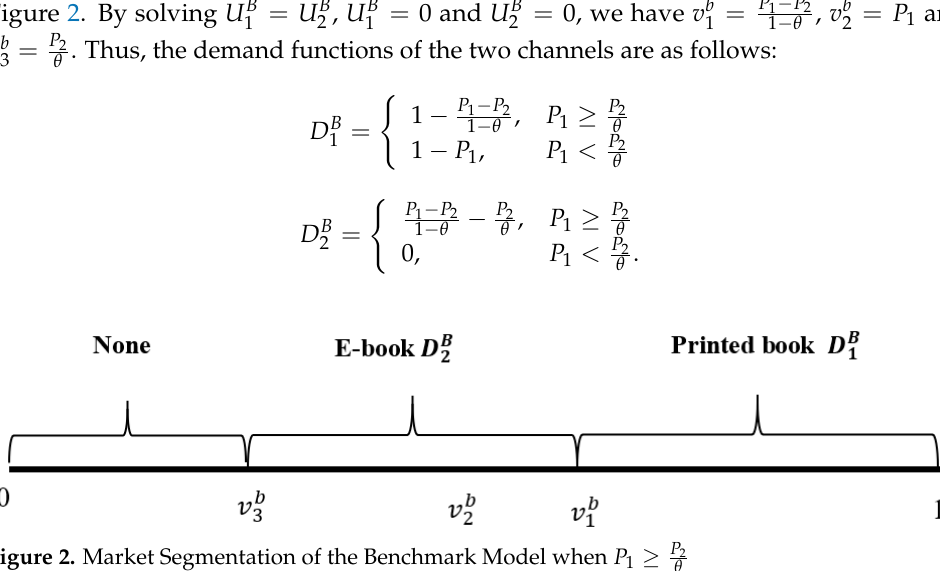
(cid:3017) (cid:3118) . (cid:3087)